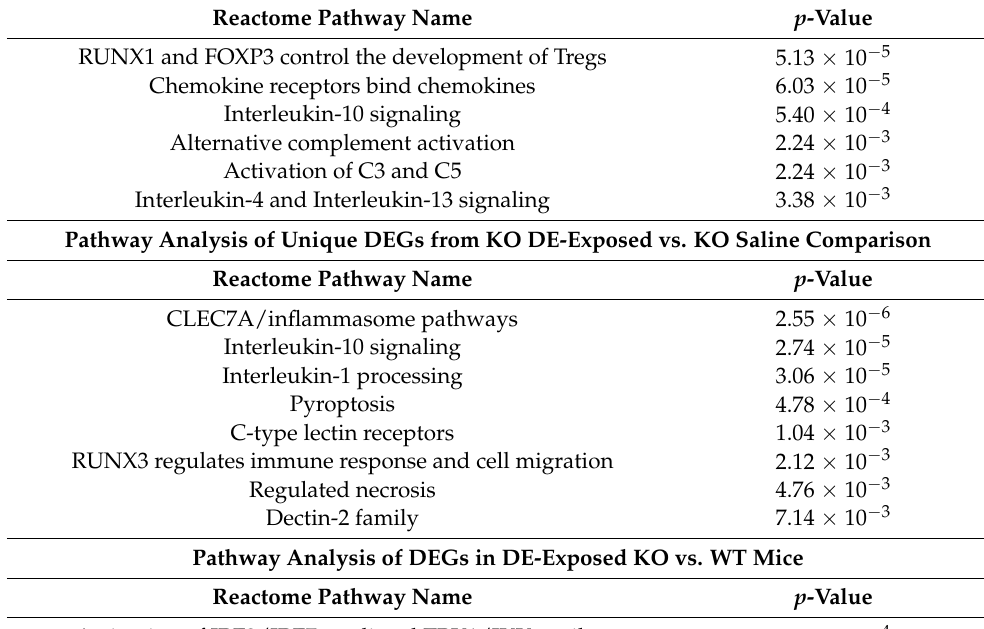
Table 1. Summary of pathway analysis findings using significant DEGs. Differentially expressed genes induced by DE exposure which were unique in WT (upper section) or KO (middle section) compared with their genotype controls were input into REACTOME, an open-source pathway database. Only genes that were unique to WT or KO with an Adj. p < 0.05 and fold-change of +/ − 1.5 × were used. (lower section) DEGs in DE-exposed KO compared with WT samples with p < 0.05 and a fold-change of +/ − 1.5 × were input into REACTOME. Only significant pathways with a p -value < 0.05 and FDR < 0.1 are reported in this